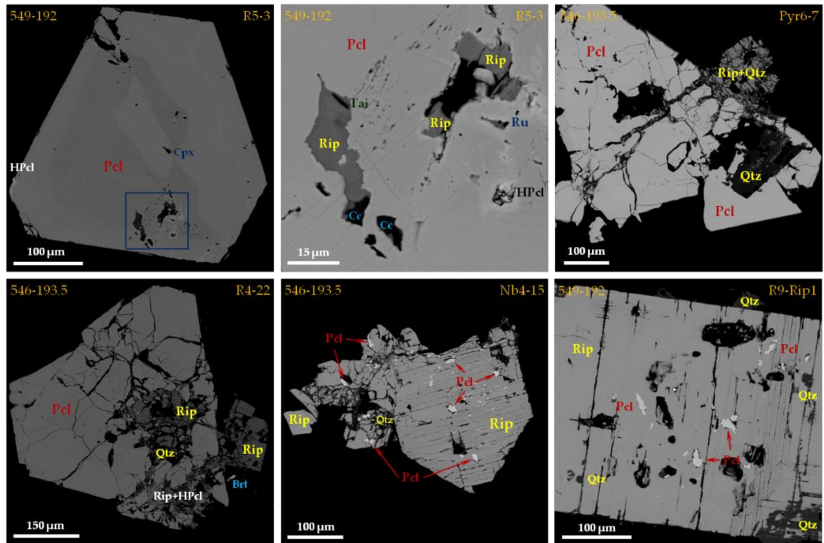
Figure 4. Relations between fluorcalciopyrochlore and rippite in the Chuktukon calciocarbonatites, BSE images.